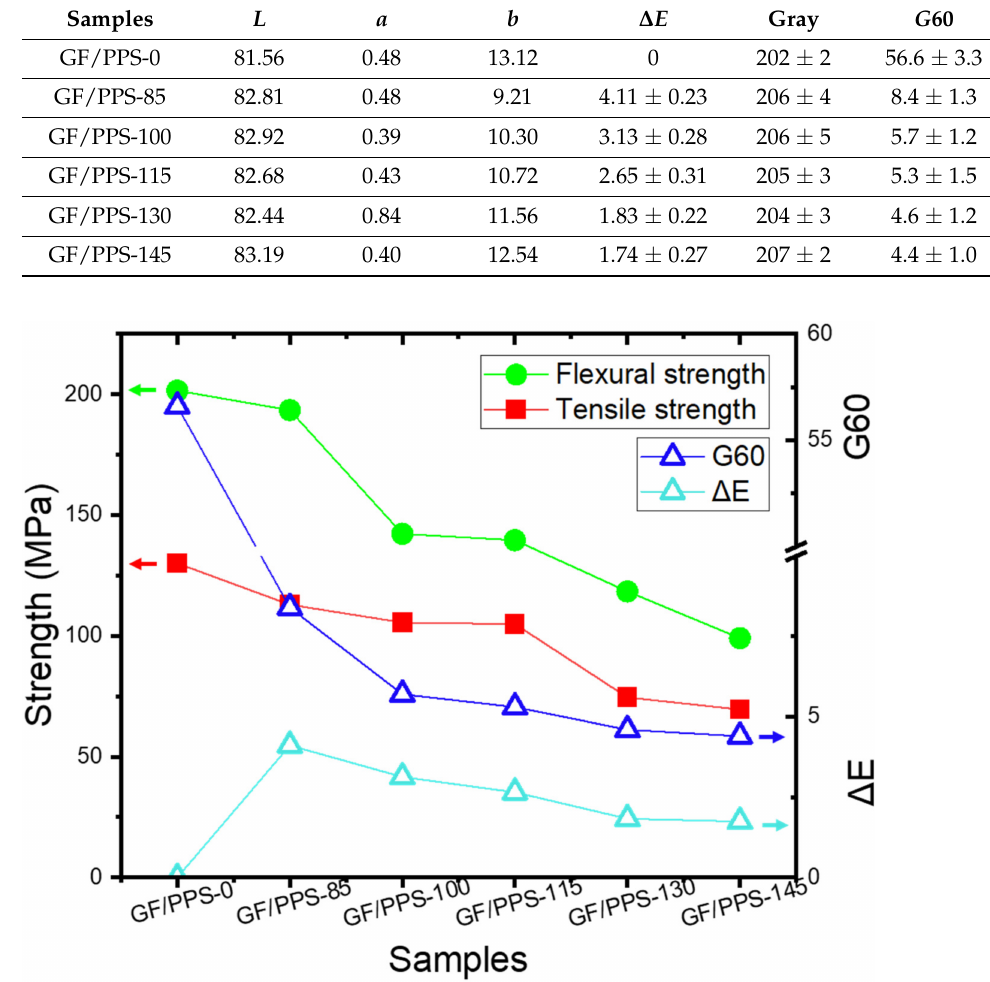
Figure 6. Correlation between mechanical strength and color difference of the GF/PPS